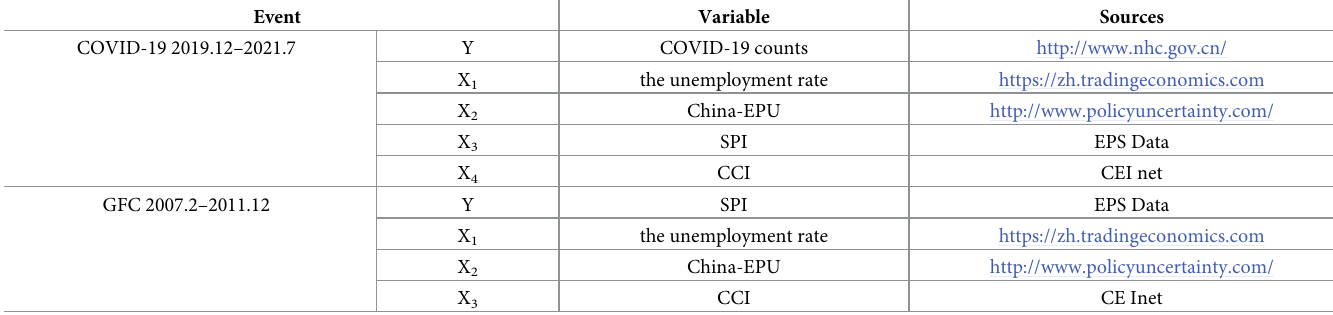
Table 1. Data and data